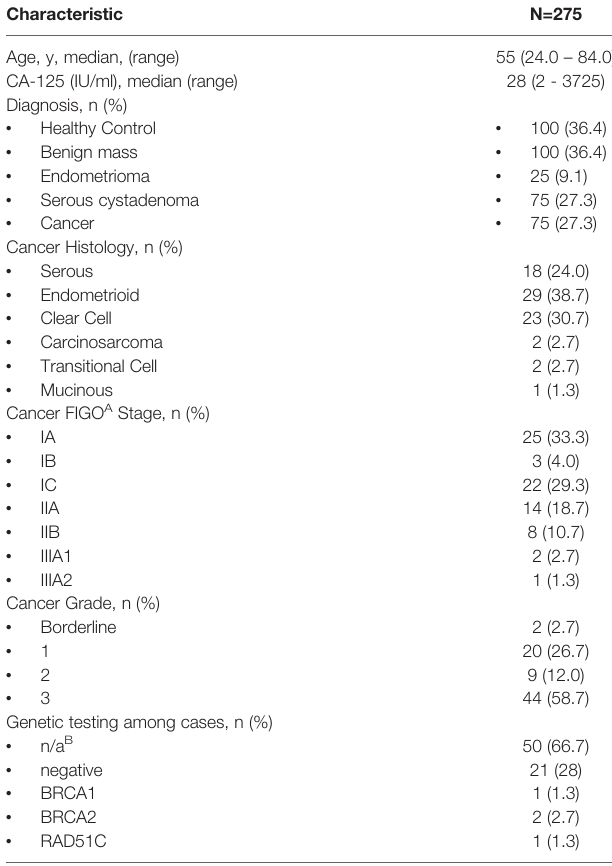
A FIGO Stage – per International Federation of Gynecology and Obstetrics 2014 staging guidelines. B n/a – not available